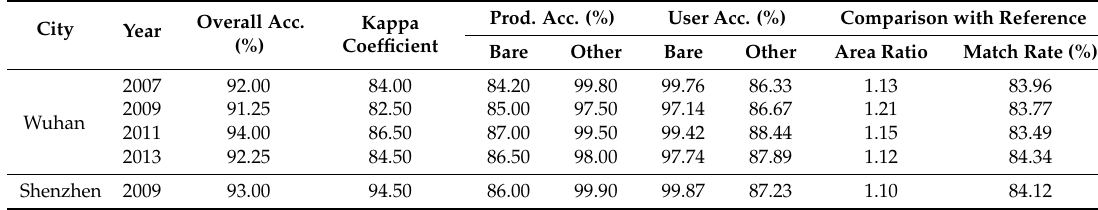
Table 4. Accuracy assessment for Wuhan and